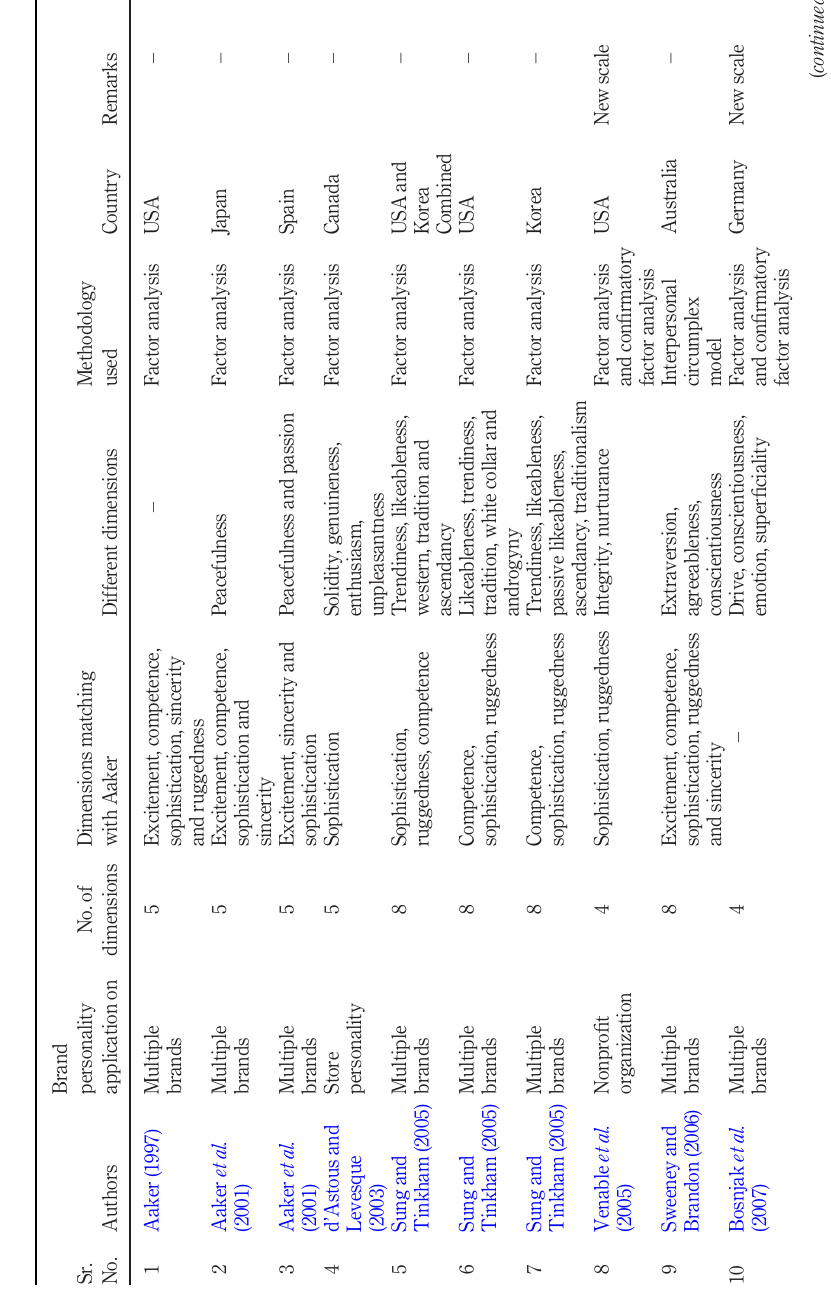
Table V. Methodology in brand personality